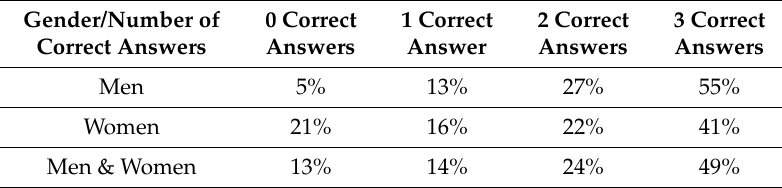
Table A10. Distribution of Number of Correct Answers on the CRT by